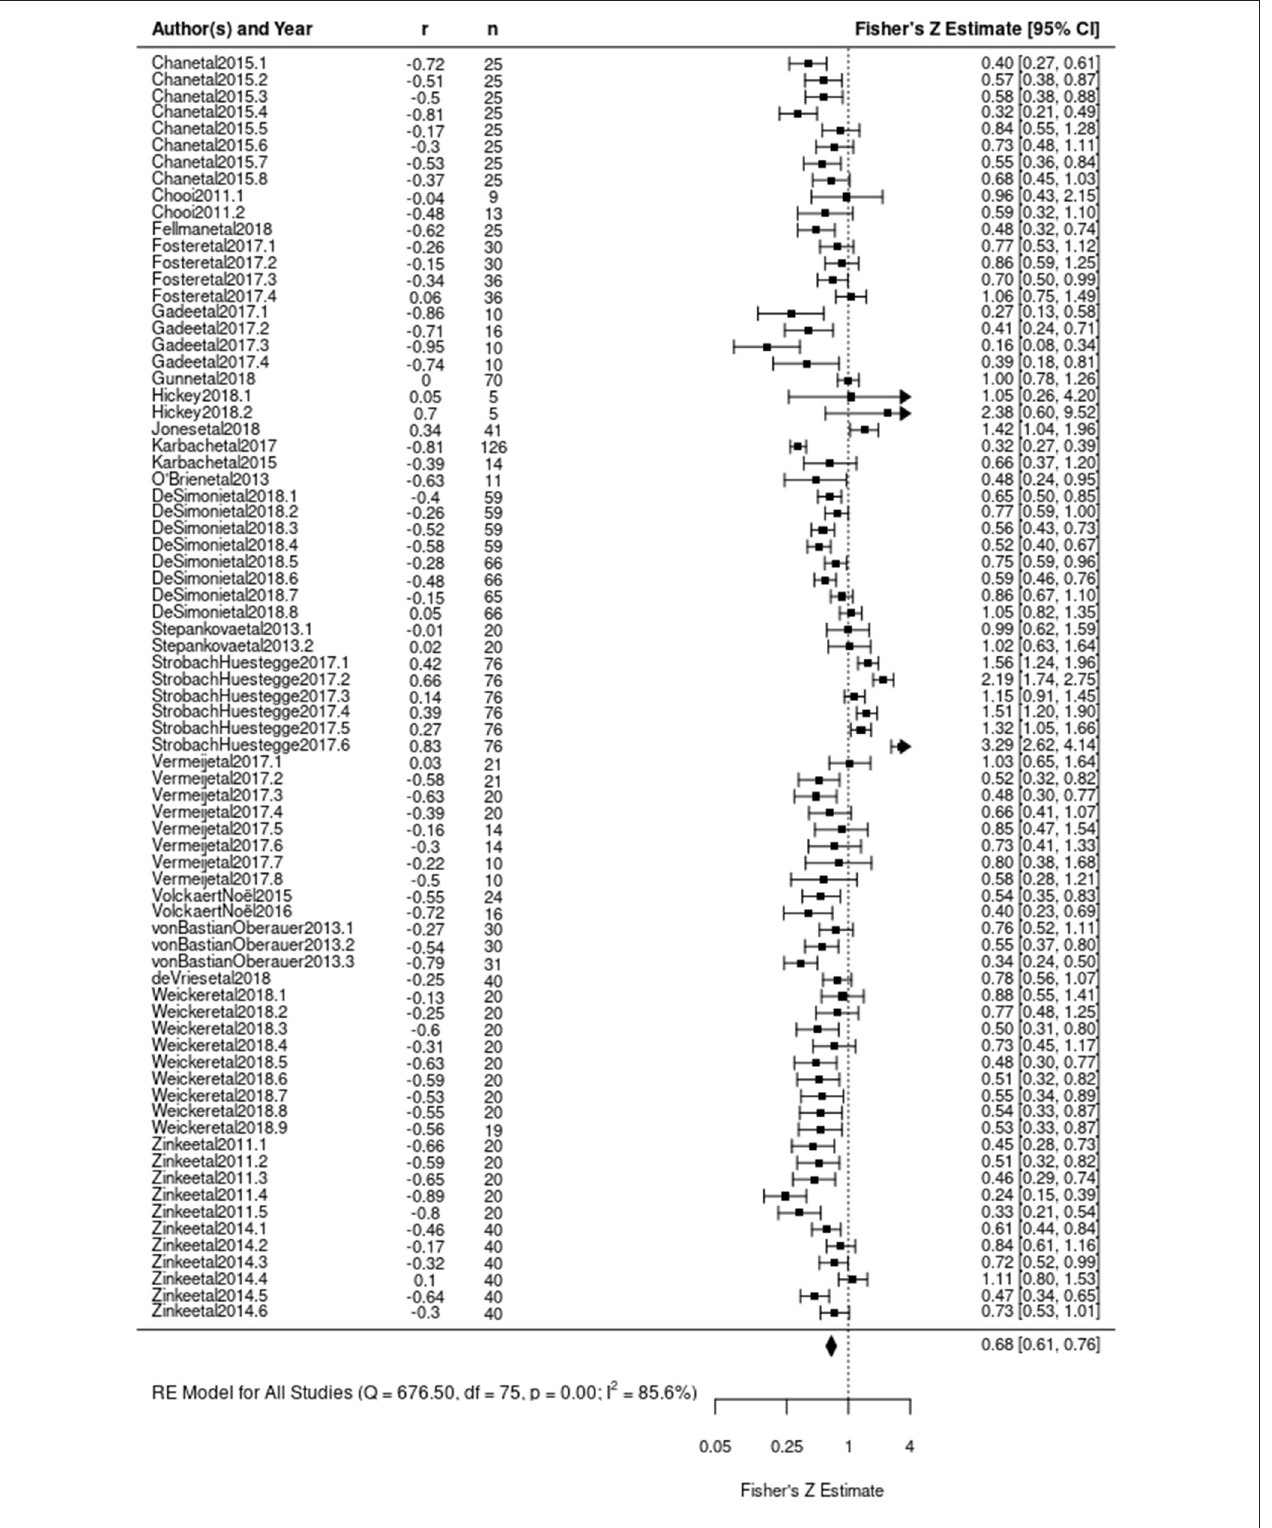
FIGURE 7 | Forest plot of Model 3 results including only executive function trainings. Each correlation coefficient is plotted according to its Fisher’s Z transformation. Size of square indicates weight assigned to the observation during analysis. Length of lines extending from square indicates variance associated with observation based on sample size. Each observation’s Fisher’s Z transformation and confidence interval are presented on the right. The diamond at the bottom indicates the estimated Fisher’s Z transformed correlation coefficient derived from Model 3.